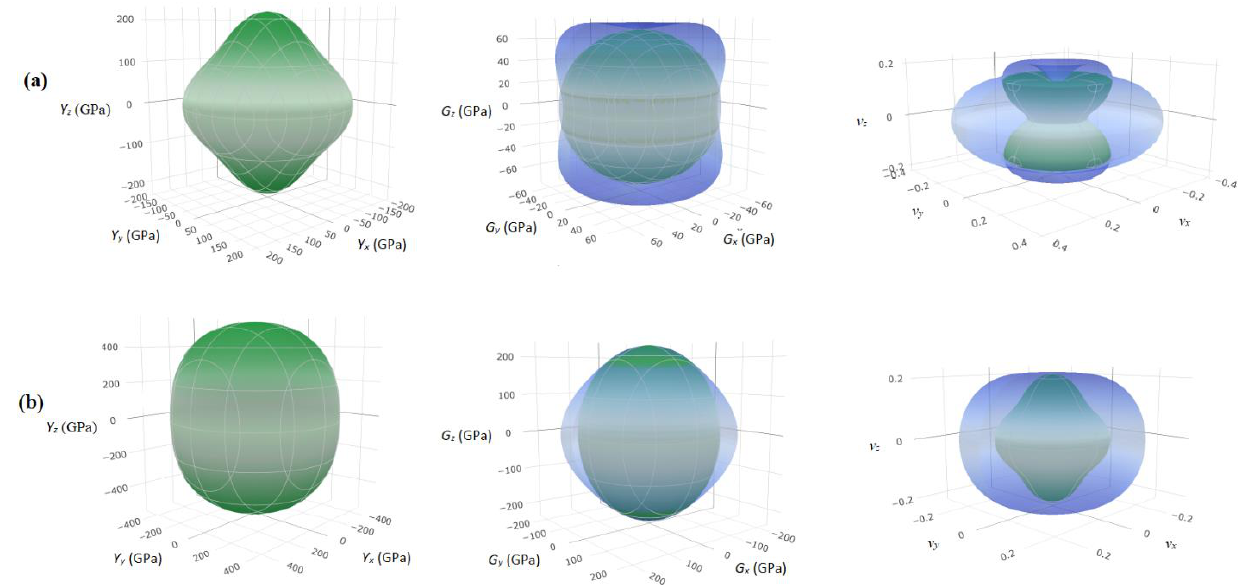
Figure 6. 3D plot of Young’s modulus, shear modulus, and Poisson’s ratio surfaces of Ti 2 PbC at pressure ( a ) 0 GPa and ( b ) 100 GPa.